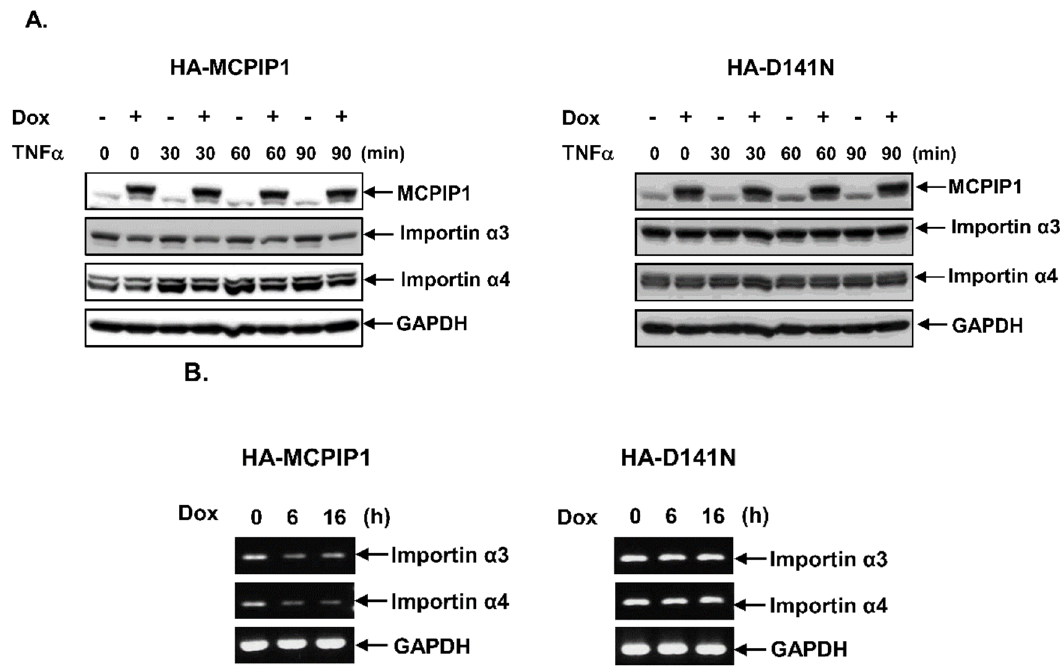
Figure 5. Overexpression of MCPIP1 decreased importin α 3 and importin α 4 expressions. ( A , B ) T-REx-293 cells with wild-type hemagglutinin (HA)-MCPIP1 or the HA-MCPIP1-D141N mutant (HA-D141N) were pretreated without or with 1 μ g/mL of doxycycline (Dox) for 16 h, and then treated without or with 10 ng/mL tumor necrosis factor (TNF)- α for 30~90 min. ( A ) Total cell lysates were collected, and protein expressions were determined by Western blotting. ( B ) Total RNA was extracted, and mRNA expression was determined by an RT-PCR.